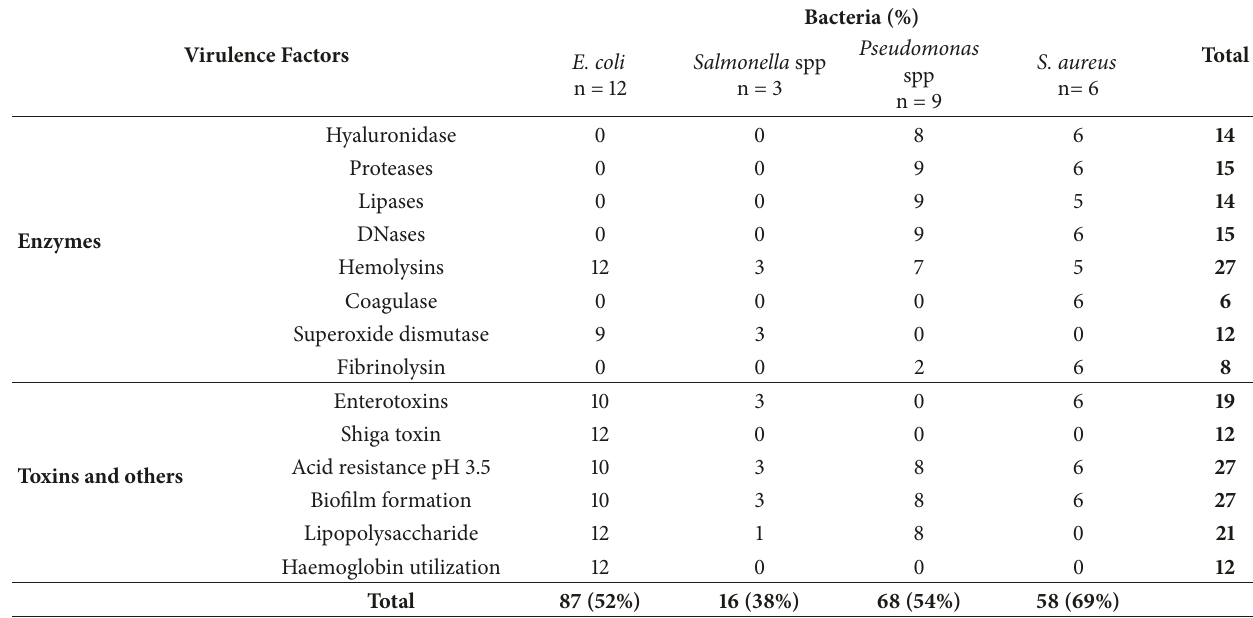
Table 4: Virulence factors characterization of the